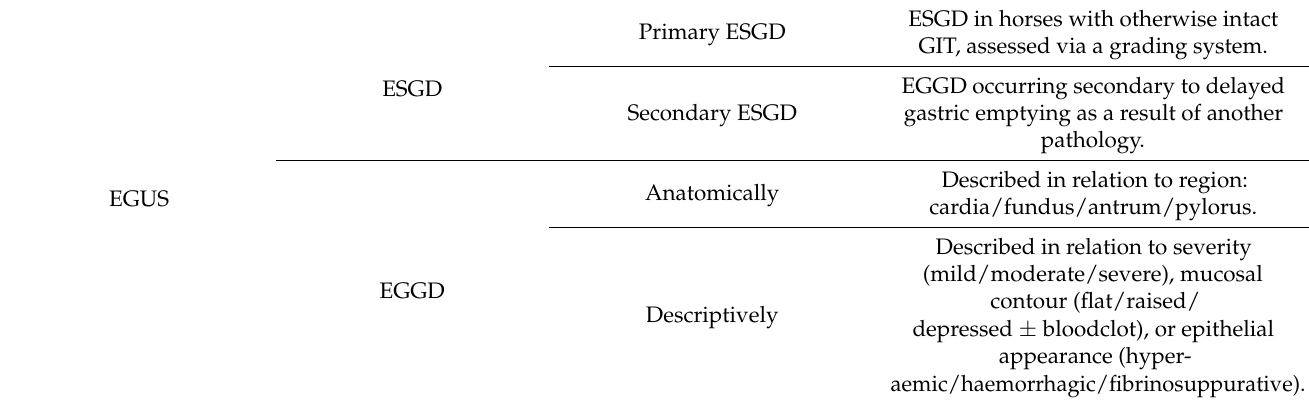
Table 1. Terminology derived from EGUS and their descriptions